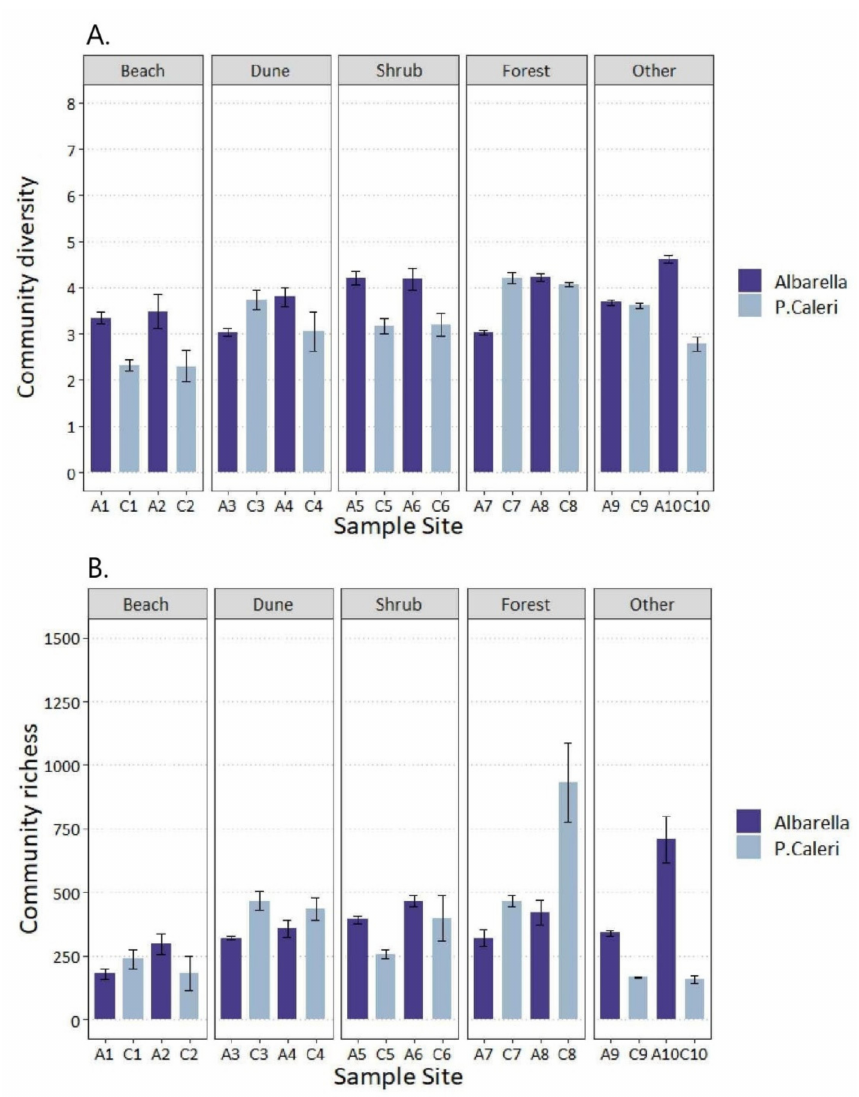
Figure 5. Soil fungal diversity at tIOTU level. Values shown in the figure are means of ( A ) Shannon– Wiener and ( B ) Chao1; vertical bars are SE (n =